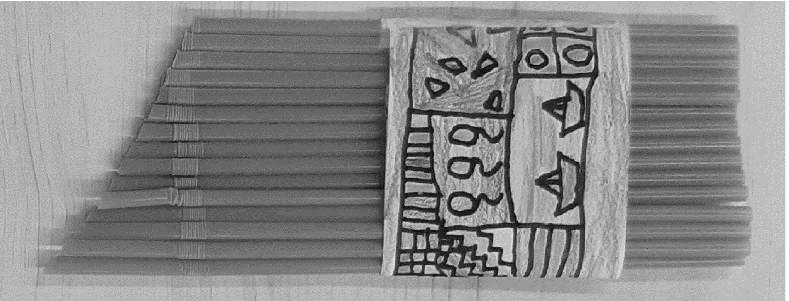
Figure 7. ‘Pan’s flute’ created by a year one pupil, with rhythmically distributed lines and points.